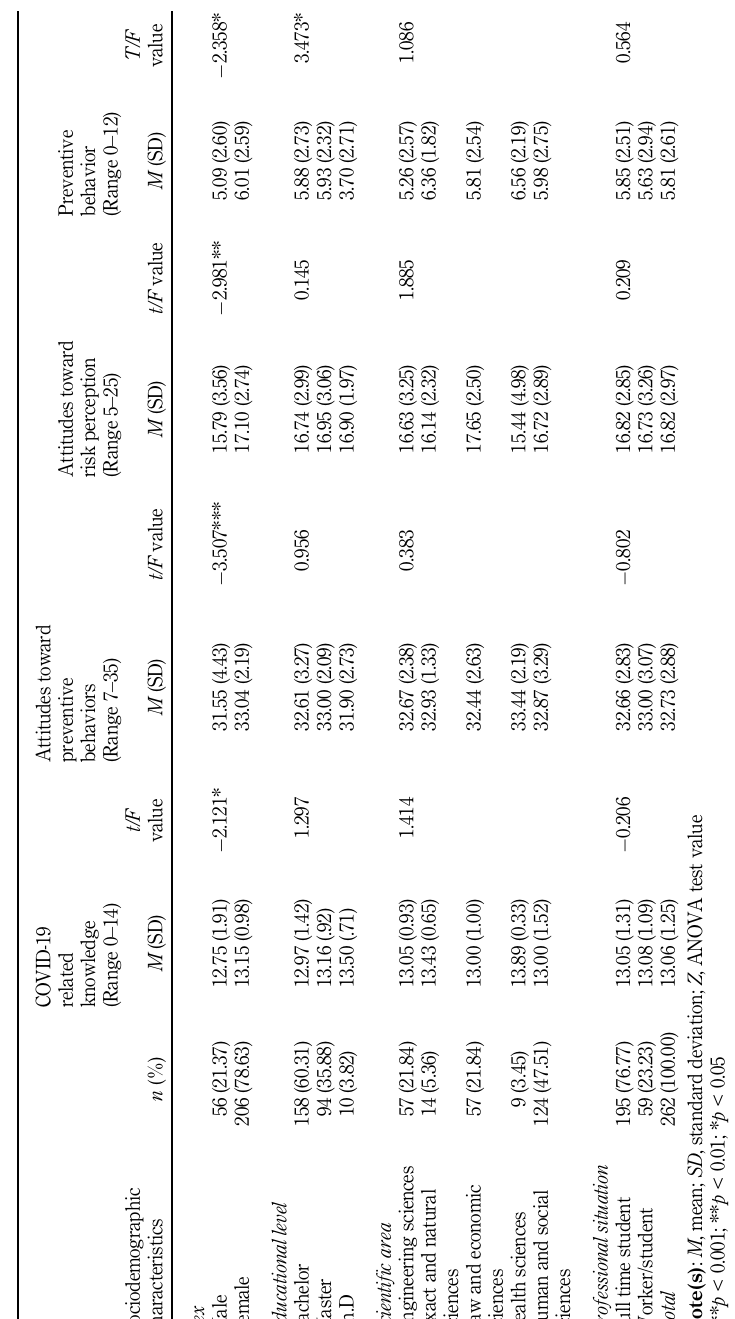
outcomes according to the sociodemographic characteristics of participants ( N 5